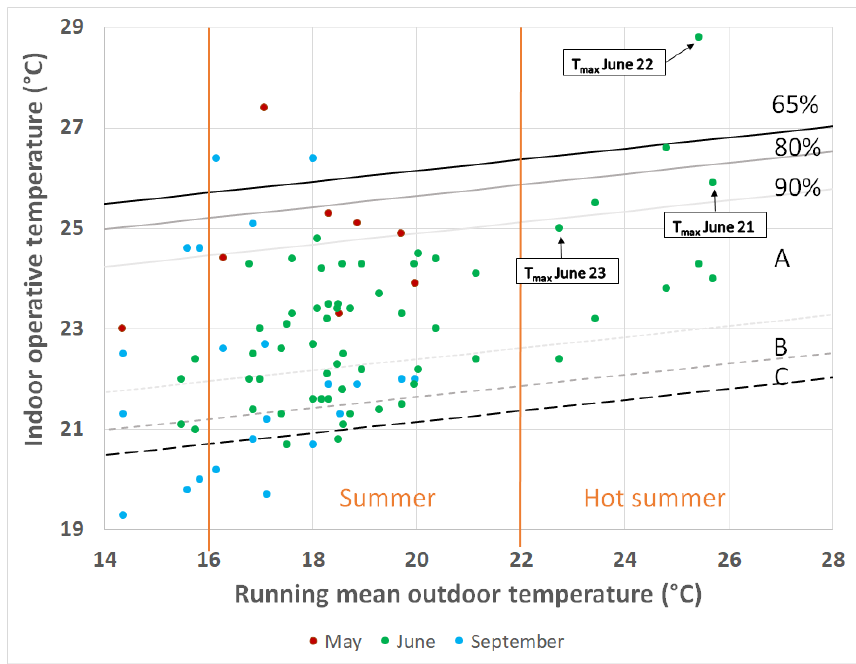
Figure 13. Thermal comfort evaluation according to the adaptive temperature limits method [34].